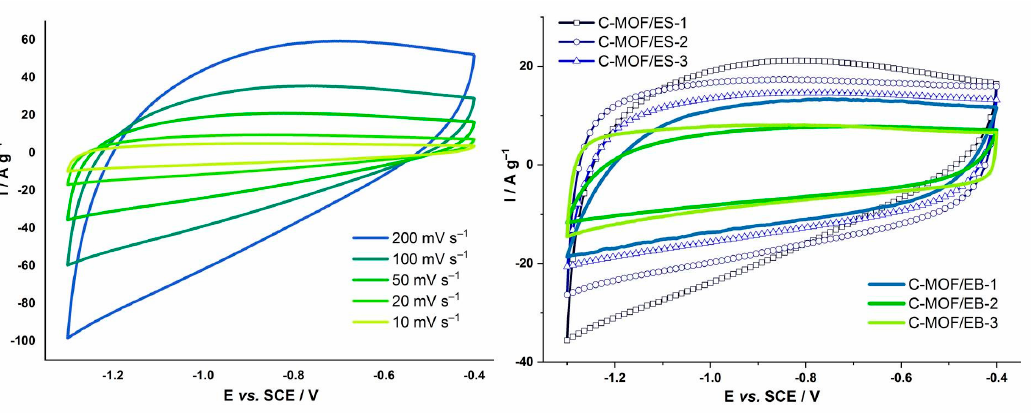
Figure 7. Cyclic voltammograms of the sample C-MOF/ES-1 measured at different potential sweep rates (v = 10, 20, 50, 100, and 200 mV s − 1 ) ( left ) and comparison of CVs between C-(MOF-5/PANI) composite samples at v = 50 mV s − 1 ( right ).